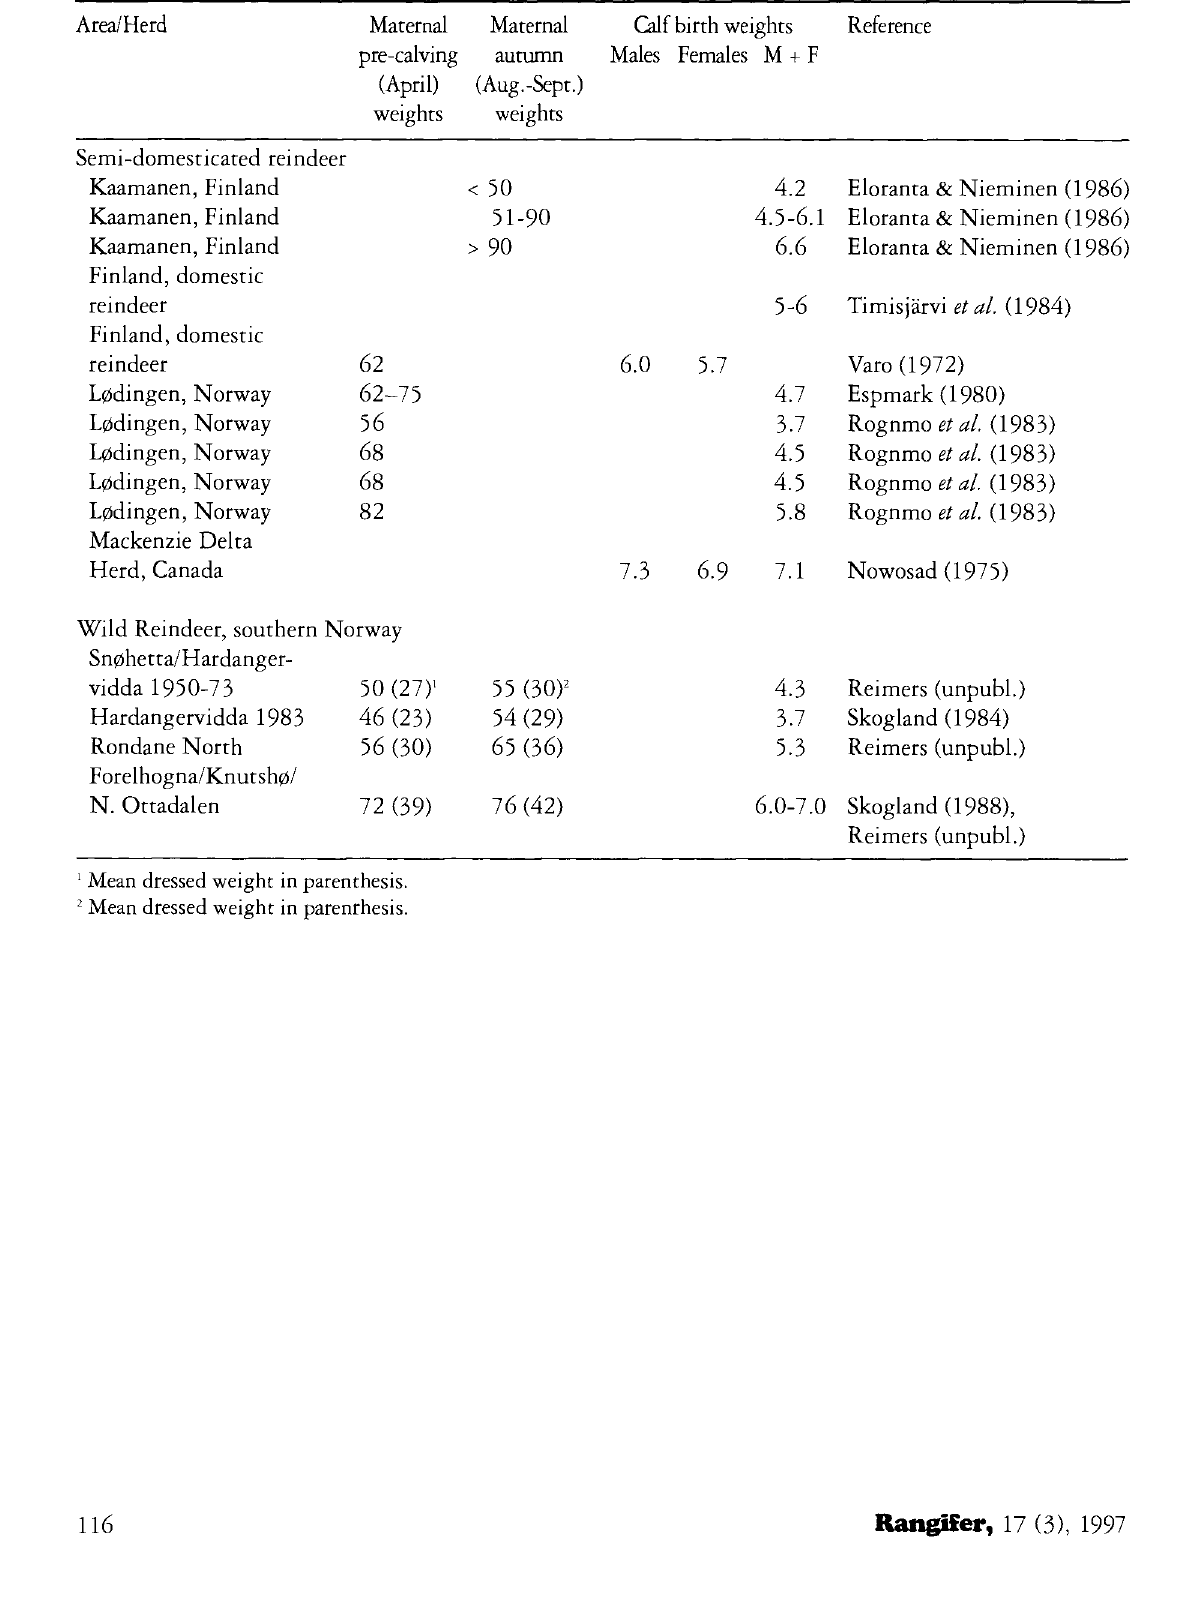
Table 3. Mean total body weights (kg) of females and newborn calves in semi-domesticated and wild reindeer.